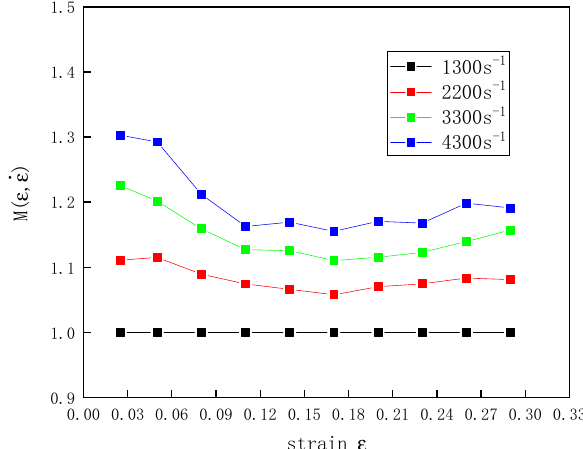
(cid:16) (cid:17) ε , . ε and ε at a temperature of 20 ◦ C and di ff erent strain rates.